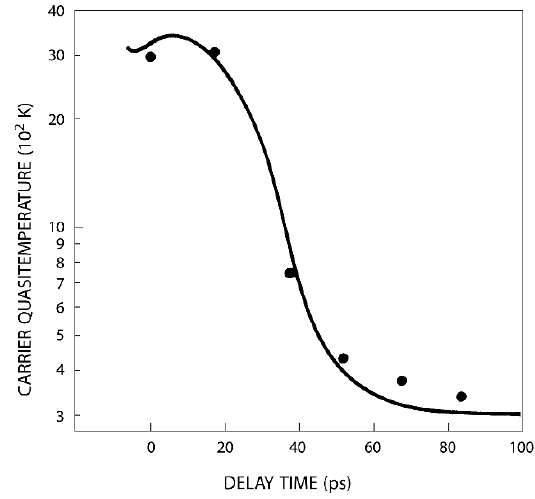
Figure 9. Evolution of the carrier quasitemperature in highly excited GaAs. The NESEF-based calculation (full line) is from Daly & Mahr 81 and experimental data (dots) are from Seymour et al. 72 .